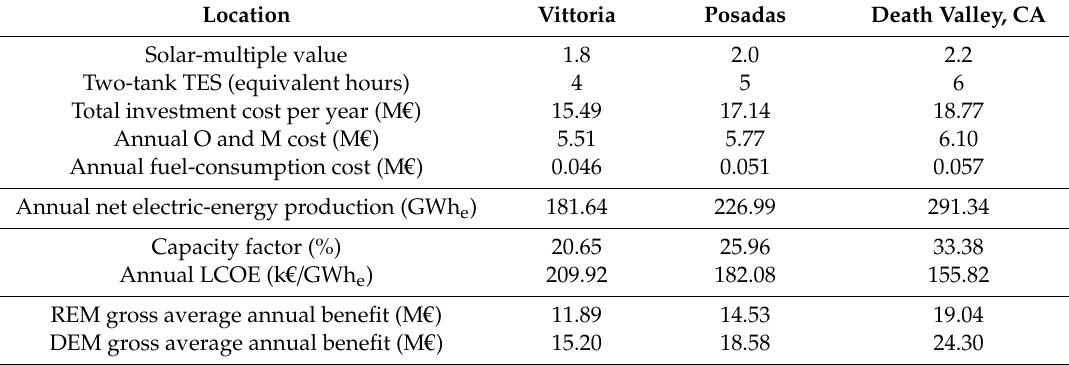
Table 8. Economic results for a 100 MW e PT power plant with two-tank molten-salt TES. Location Vittoria Posadas Death Valley,